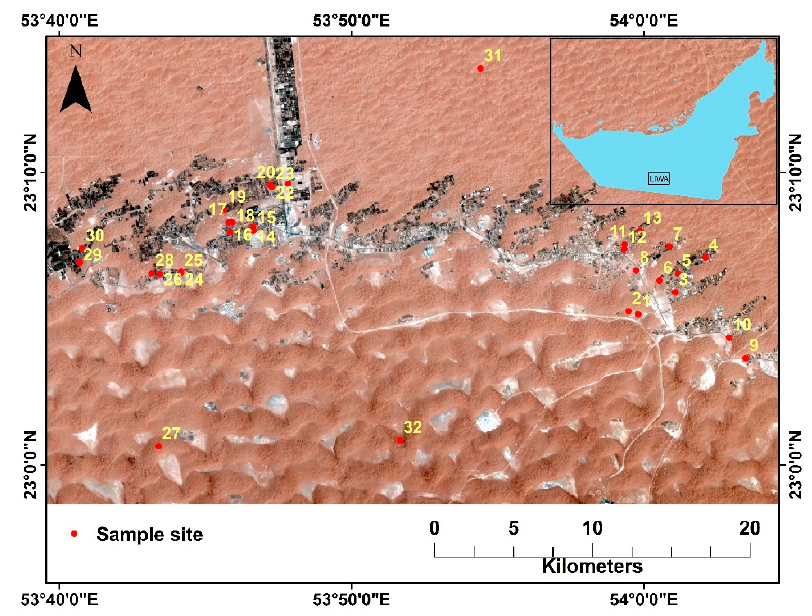
Figure 1. Location map of the study area and sampling sites, Liwa, Abu Dhabi.